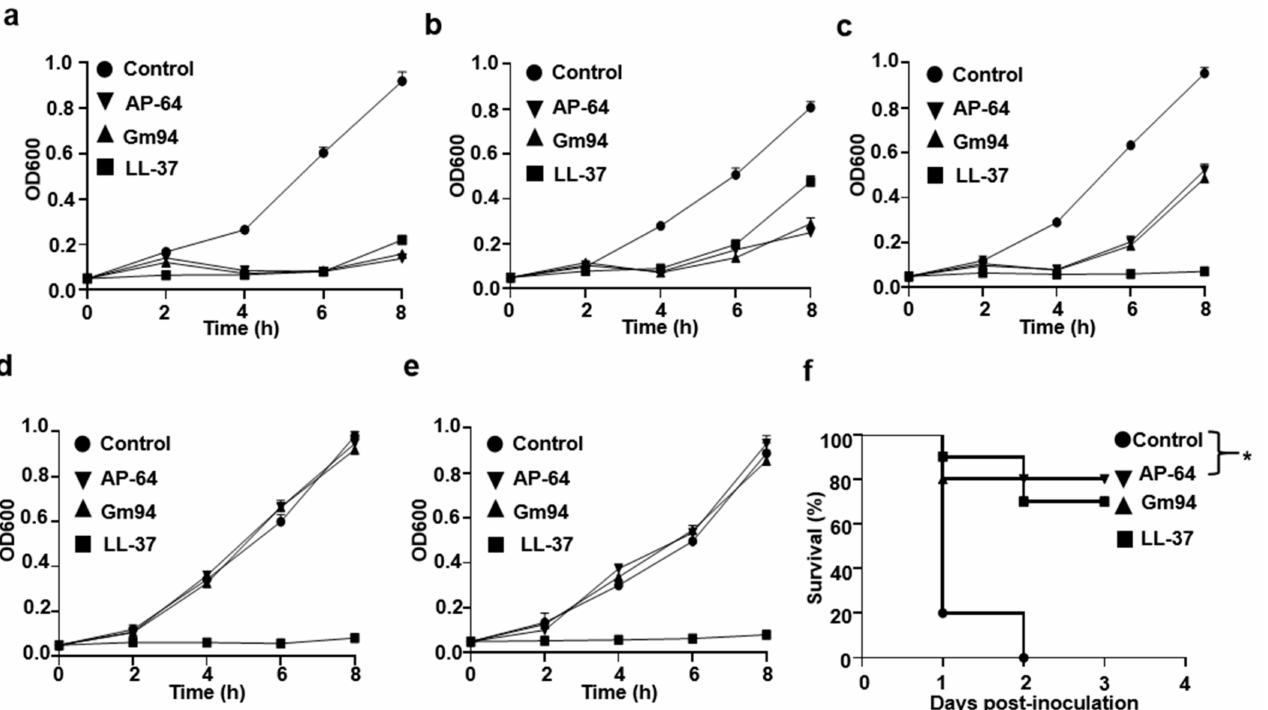
Figure 4. Antibacterial activity against pathogenic bacteria. ( a – e ) Growth curve of O157:H7 ( a ) Vibrio cholerae , ( b ) Pseu- domonas aeruginosa ( c ), Staphylococcus aureus ( d ), and Listeria monocytogenes ( e ) cells exposed to the recombinant proteins (10 µ M). The proteins were added to the bacteria at time 0. All error bars represent SD. ( f ) Enhanced resistance to O157:H7 infection after treatment with AP-64 or Gm94 in mice (n = 10 mice/group). Thirty minutes after the intraperitoneal inoculation of 5.0 × 10 6 CFU of O157:H7, mice were injected intraperitoneally with the indicated proteins. The dosage of proteins was 500 µ g/kg of body weight. A log-rank test was used to analyze the overall survival of the mice (* p <